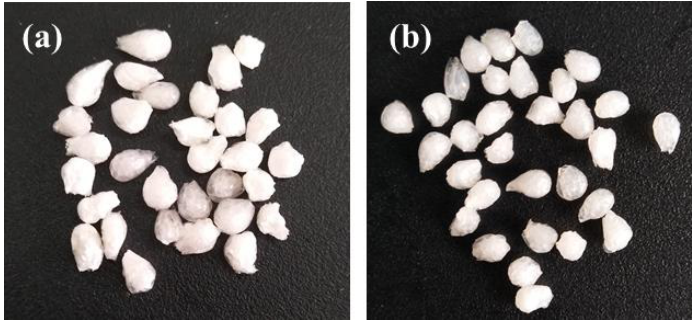
Figure 10. Images of the Alg-Mel ( a ) before adsorption and ( b ) after recycling ten times.